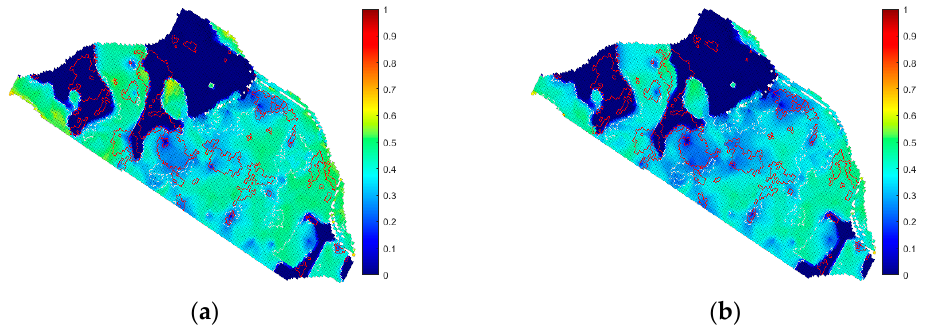
Figure 24. Remaining oil distribution before and after flow-field adjustment in the 21st layer. ( a ) Before adjustment; ( b ) after adjustment.